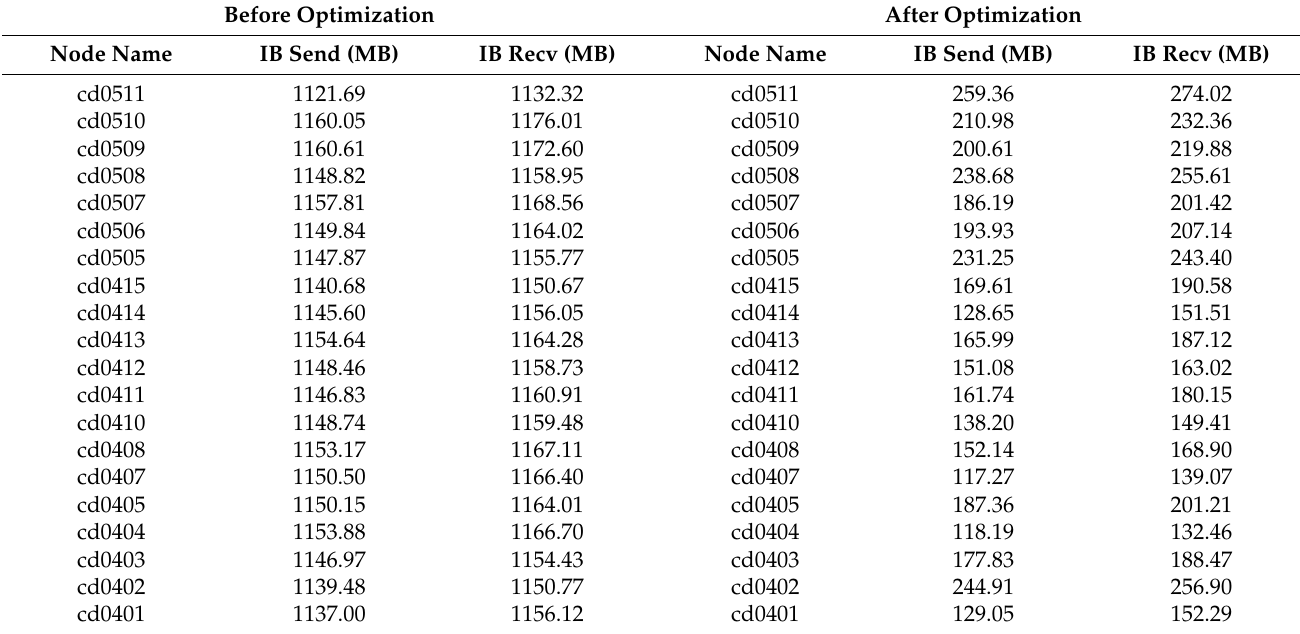
Table 4. The Paramon monitoring info of data exchange across nodes of 18-ring on Platform 2. Before